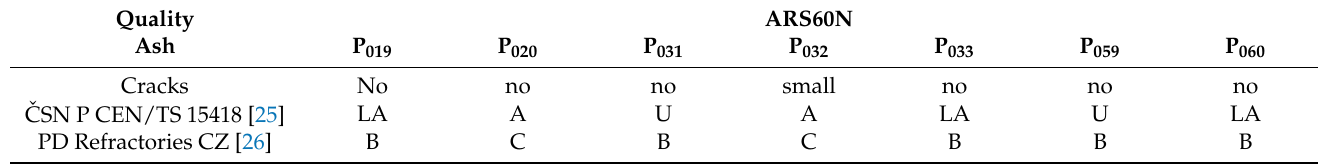
Table 8. Evaluation corrosion of refractory materials ARS60N at temperature 1200 ◦